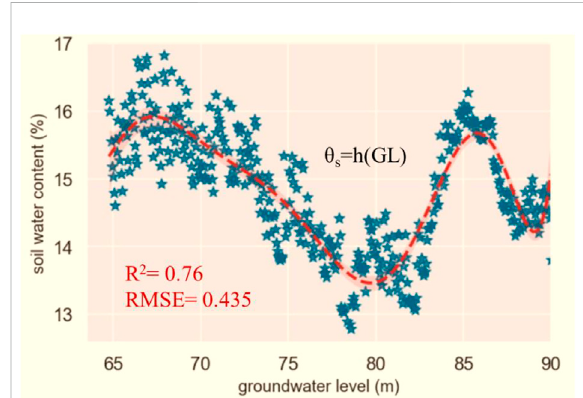
FIGURE 5 Evidence for groundwater level (GL) as a leading variable in Eq.13showingevident fl uctuationsin θ s whenGLvariesfrom65to 90 m in irrigation seasons. Note: function h is an eight-degree polynomial. The coef fi cients of the 8th, 7th, 6th, 5th, 4th, 3rd, 2nd, and 1st order terms are 3.488e − 08, − 2.114e − 05,